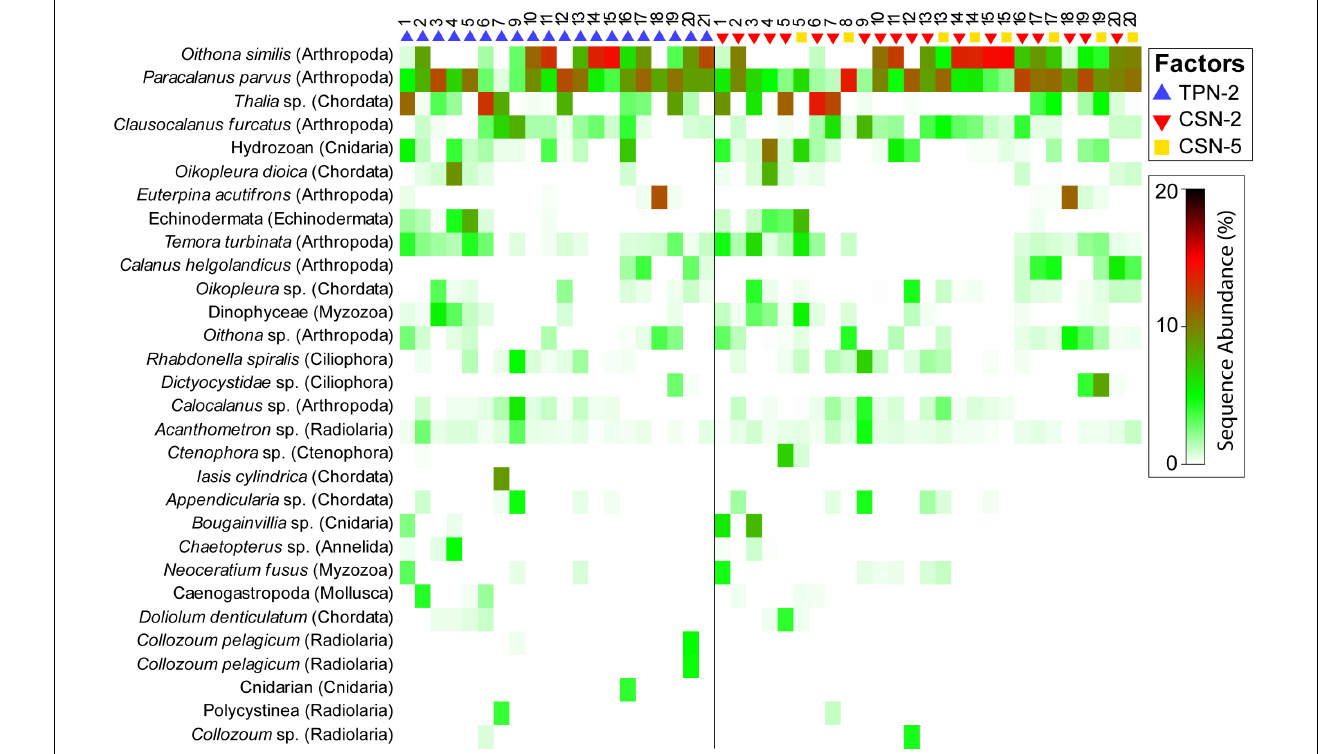
FIGURE 4 | Shade plot displaying the 30 most abundant Amplicon Sequence Variants (ASVs, y -axis, assignment at lowest assignable taxonomic level is indicated to the left, with corresponding phylum in parenthesis) amongst all New Zealand samples. The data are divided into Traditional Plankton Net at < 3 knots (TPN2), Cruising Speed Net at < 3 knots (CSN2), and at > 3 knots